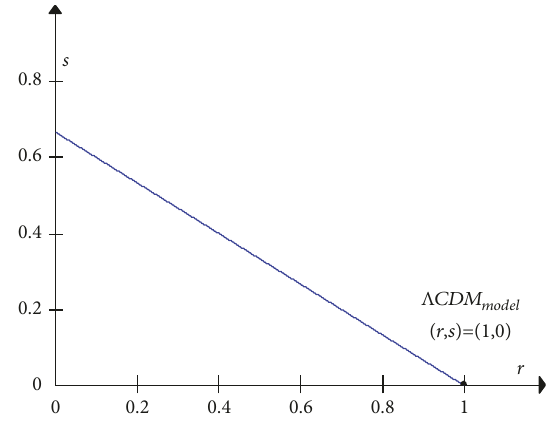
Figure 10: The plot of statefinder parameters 𝑠 versus 𝑟